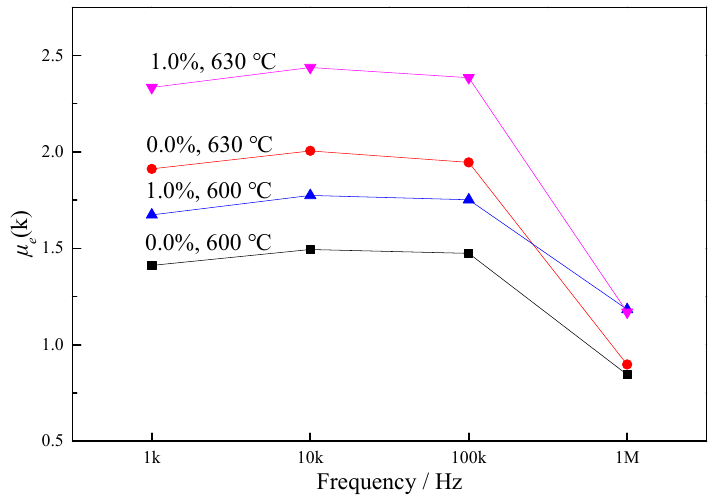
Figure 8. Dynamic soft magnetic performance after tension annealing.